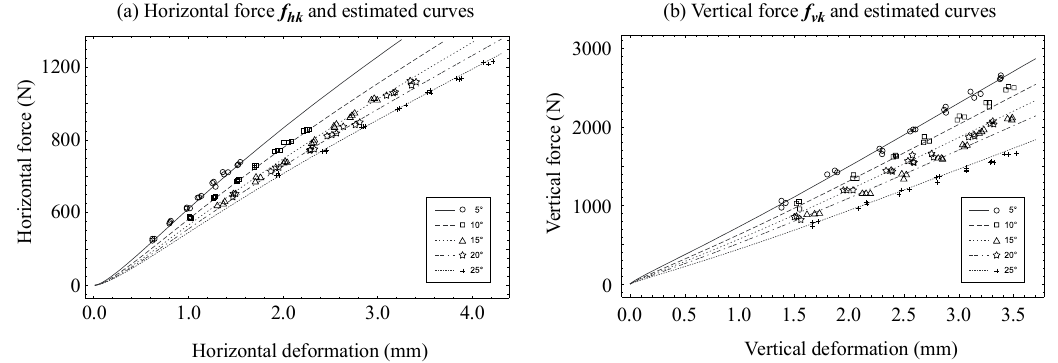
Figure 3. Experimental deformation-force pair where the deformation velocity equaled zero in each impact test, and the estimation curves from parameter identification in the horizontal element ( a ), and vertical element ( b